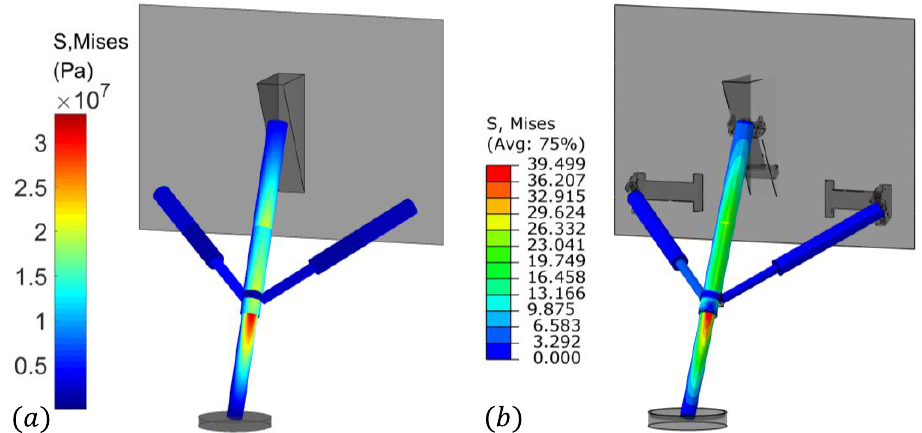
Figure 5. The statistical analysis results of the lander: ( a ) theoretical results and ( b ) FEA simu- lation results.